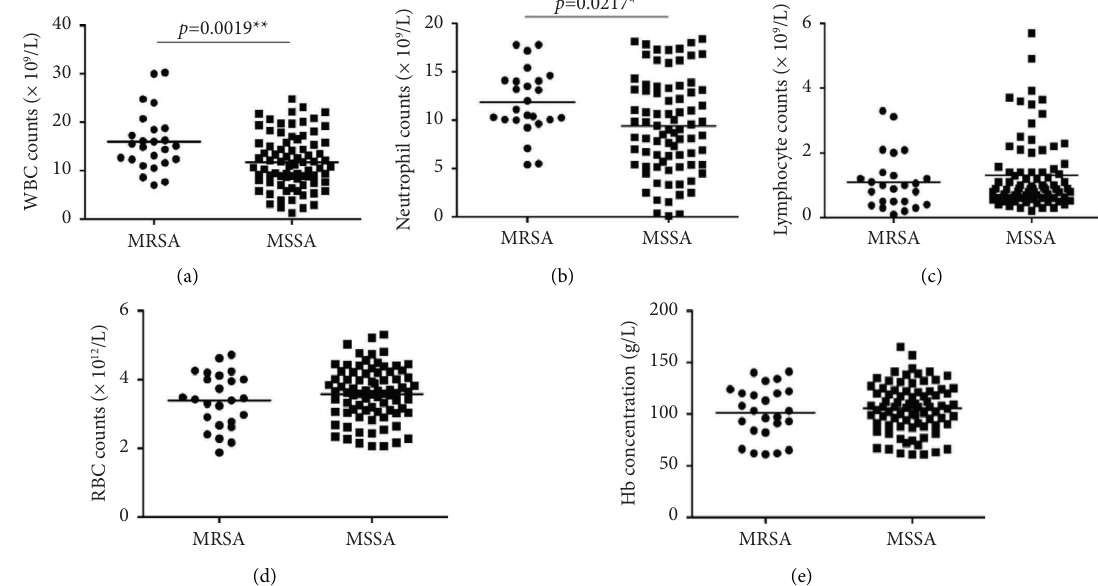
Figure 3: Comparison of blood count of patients infected with MRSA or MSSA. (a) WBC counts. (b) Neutrophil counts. (c) Lymphocyte counts. (d) RBC count. (e) Hb